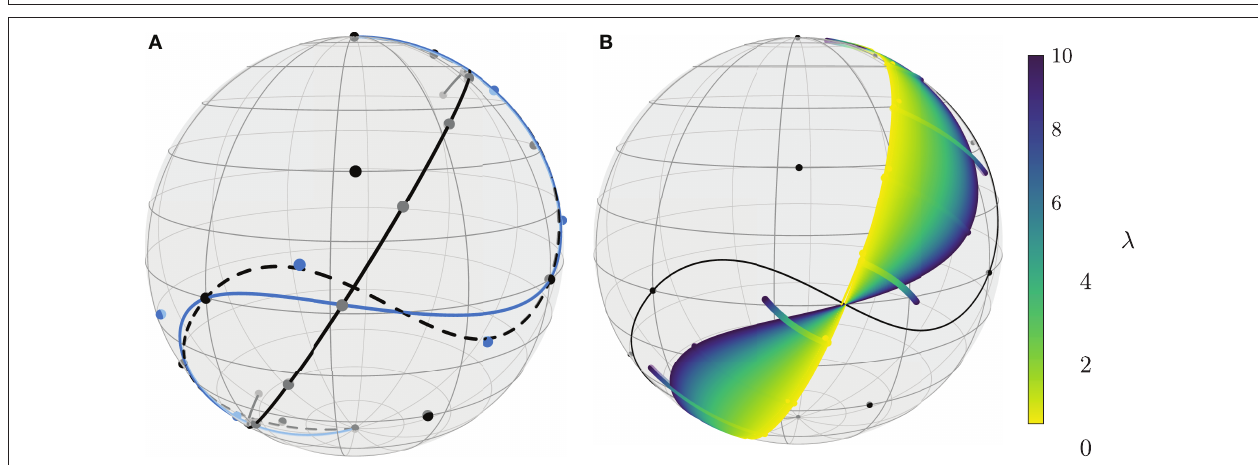
FIGURE 9 | The composite Bézier curves are composed of three segments. The initial curve (dashed, A ) is optimized with the interpolating model (solid blue, A ) as well as with the fitting model for a continuum of values of λ , from λ geodesic (solid black, A